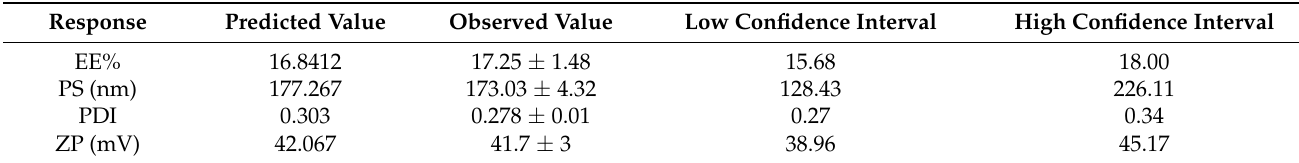
Table 5. Validation of the optimization